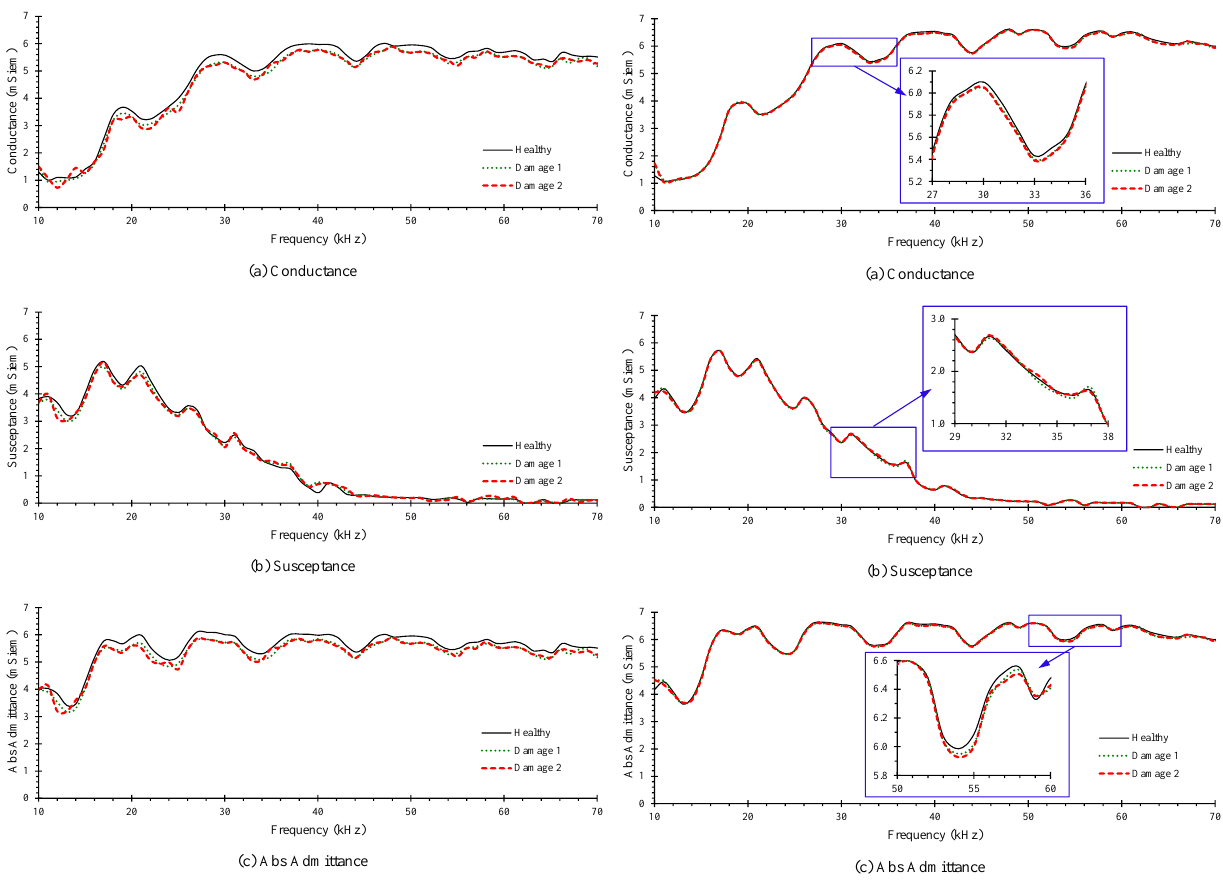
Figure 7. Comparisons of the embedded “smart aggregate” transducer PZT4 measurements of Figure 8. Comparisons of the externally epoxy bonded transducer PZTX8 measurements of Figure 7: Comparisons of the embedded “smart aggregate” trans- Figure 8: Comparisons of the externally epoxy bonded transducer admittance (conductance, susceptance and abs admittance) between the healthy state and the admittance (conductance, susceptance and abs admittance) between the healthy state and the ducer PZT4 measurements of admittance (conductance, suscep- two damage levels (Damage 1 and Damage 2) of the RC beam PZTX8 measurements of admittance (conductance, susceptance two damage levels (Damage 1 and Damage 2) of the RC beam tance and abs admittance) between the healthy state and the two and abs admittance) between the healthy state and the two damage damage levels (Damage 1 and Damage 2) of the RC beam levels (Damage 1 and Damage 2) of the RC beam